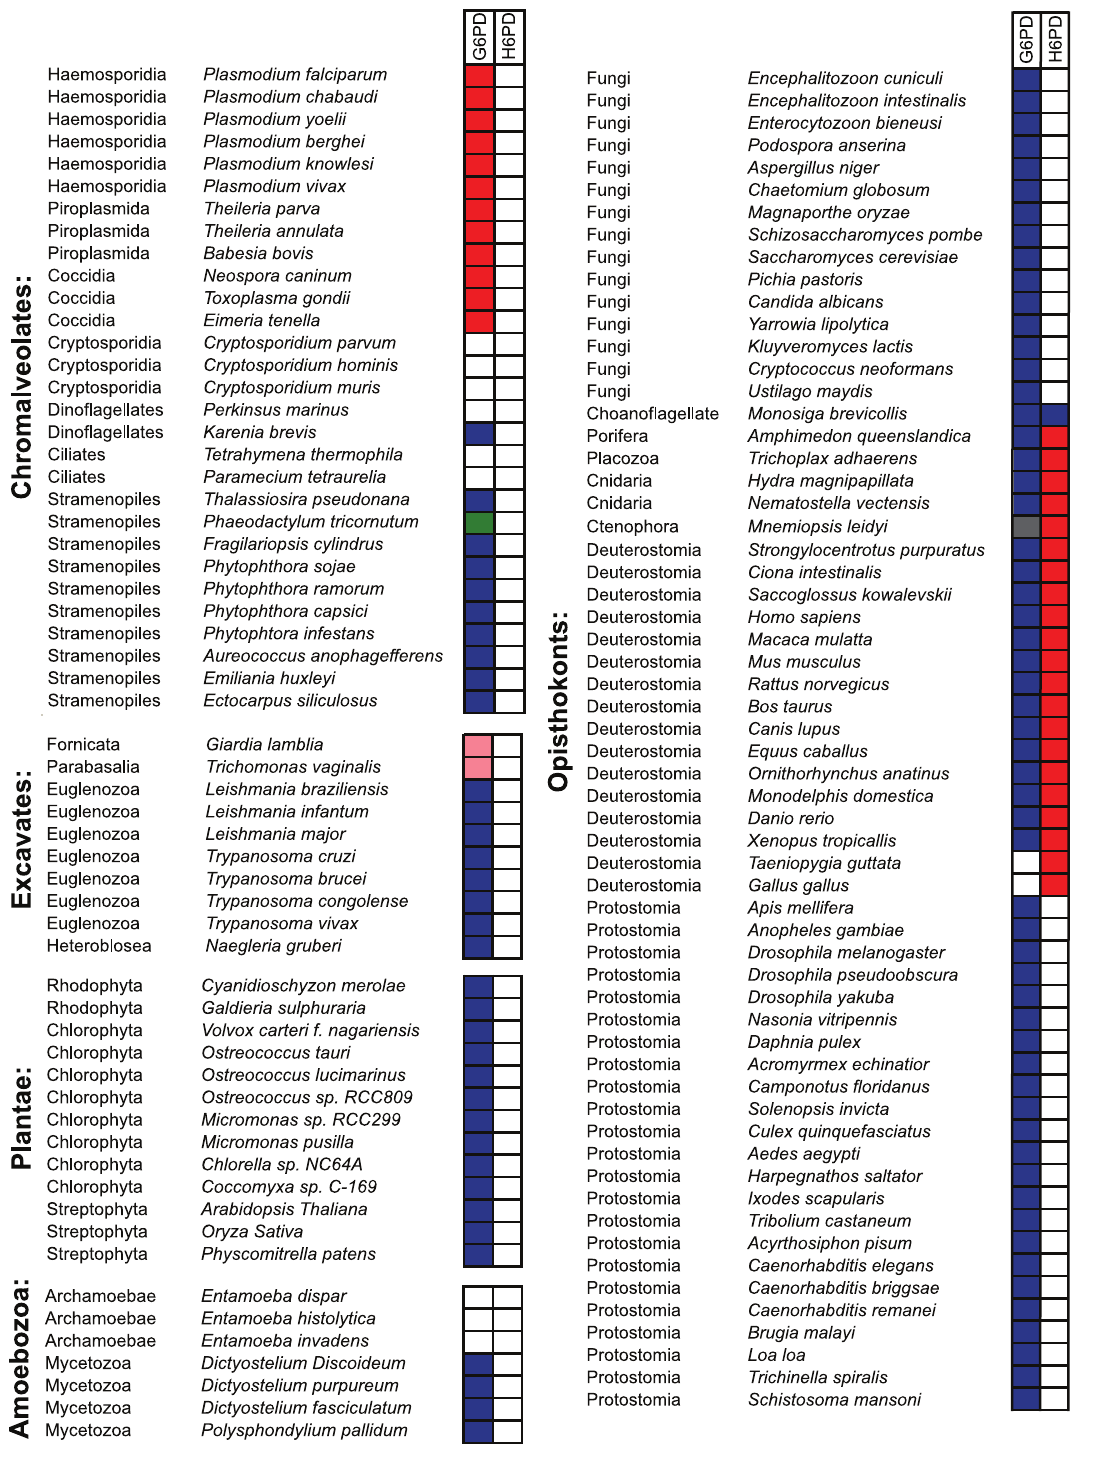
Figure 2. Species used in this study and their G6PD homologs. The species listed are divided into the major eukaryotic supergroups and subtaxa mentioned in the text. The Rhizaria is absent due to the lack of a fully sequenced genome from this supergroup. The two boxes show the fusion state of the G6PD and H6PD orthologs in each species. Red boxes represent a G6PD or H6PD at the N-terminus and 6PGL at the C-terminus; pink boxes represent a fusion with 6PGL at the N-terminus and G6PD at the C-terminus; blue boxes indicate the presence of a free, non-fused G6PD; the green box represents a fusion between G6PD and 6PGD; white boxes indicates that the species lacks a G6PD or H6PD ortholog. The grey box by the ctenophoran Mnemiopsis leidyi indicates that we could not identify a G6PD ortholog in this species, but, because we used only EST sequences, we cannot determine if G6PD is absent. Table S1 lists the accession numbers for all G6PD and H6PD orthologs shown in the figure.